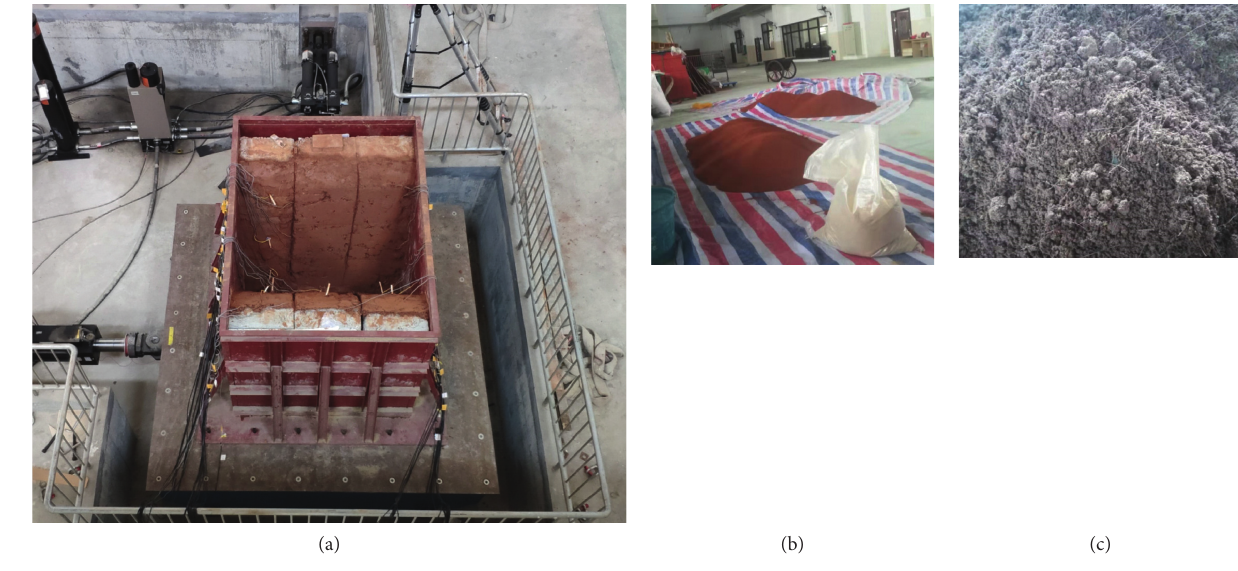
Figure 7: The substrate laying.